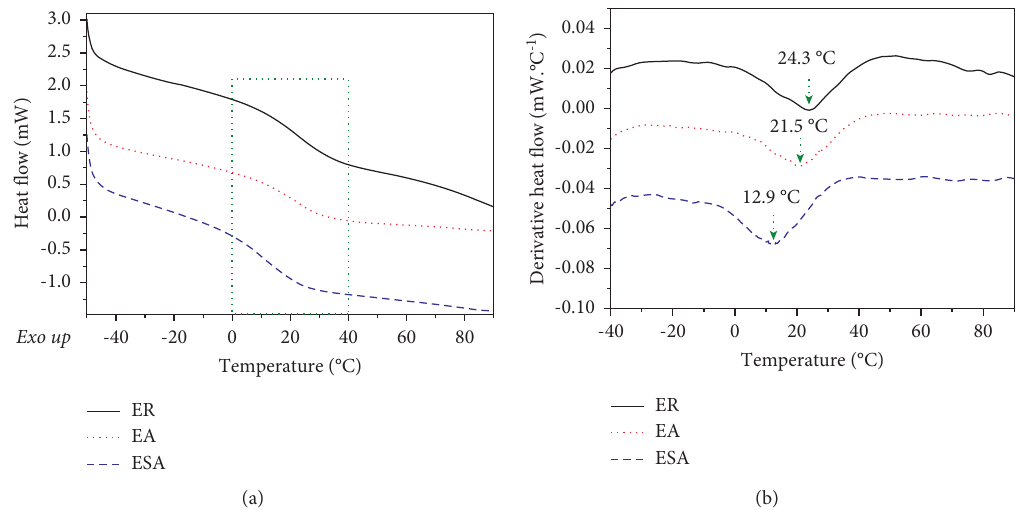
Figure 13: Nonisothermal DSC curves (a) and derivative of DSC curves of ER, EA, and ESA samples (b) [68]. Note: ER � epoxy resin; EA � epoxy asphalt; ESA � epoxy asphalt with